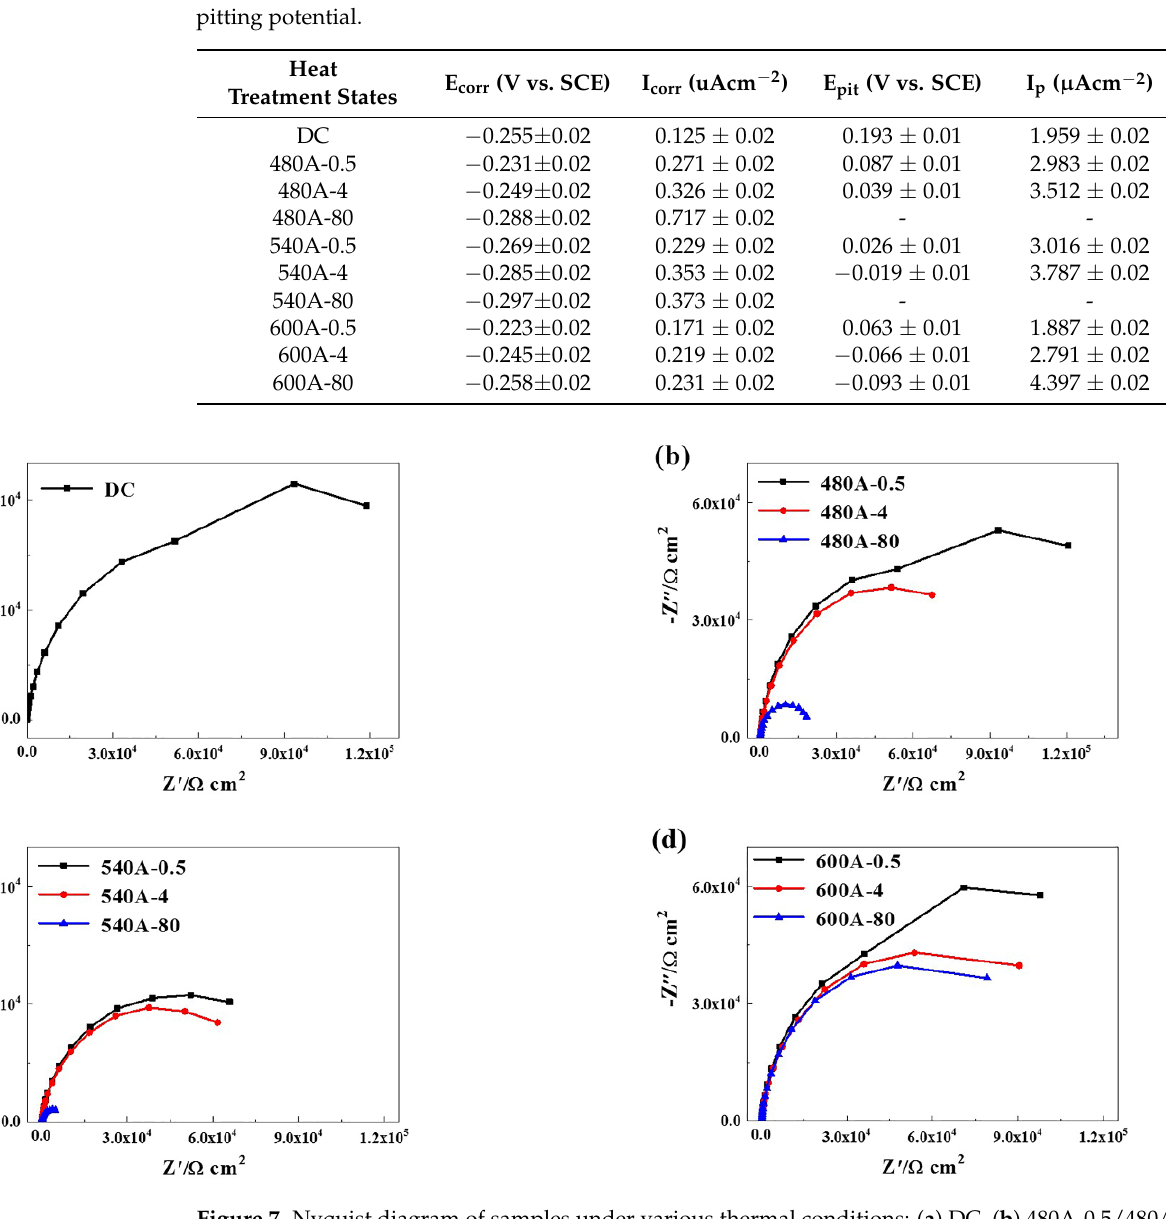
Table 2. Fitting parameters of the potentiodynamic polarization curve of specimens in 3.5 wt.% NaCl